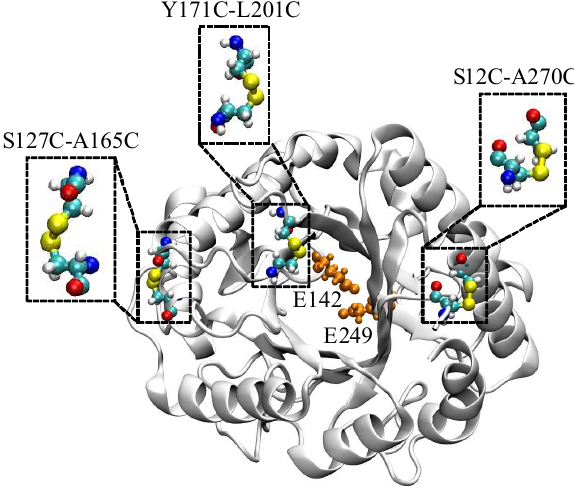
Figure 1. The three potential disulfide bonds in EGLII (PDB ID: 5L9C, chain A) used for the experimental studies: Catalytic residues E142 and E249 in the enzyme active site are shown in orange.